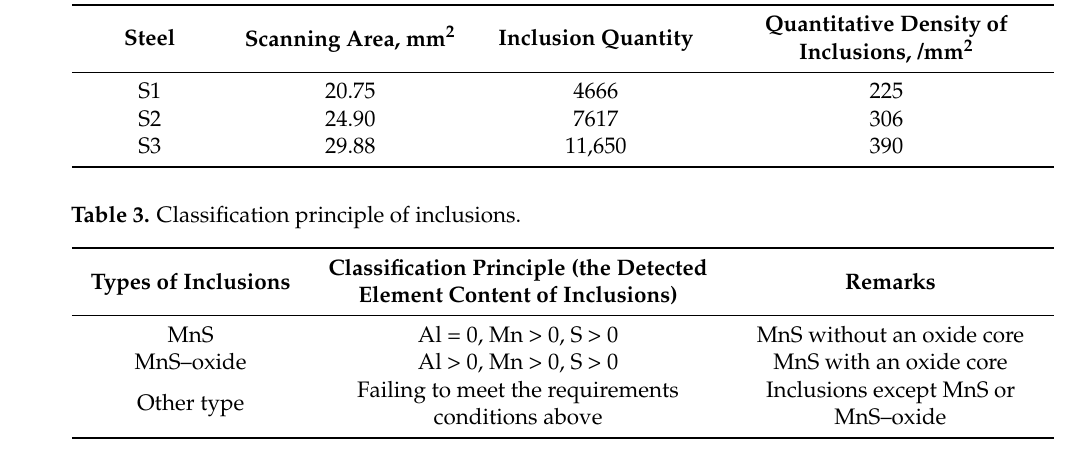
Figure 4. Types and percentage of sulfides in samples. 3.2. Morphology and Size of MnS Inclusions in Rolled Samples The morphology of inclusions affect the mechanical properties of steel. Diederichs [29] found that large-sized elongated MnS inclusions lead to the anisotropic properties of steel. Therefore, in this paper, the aspect ratio of sulfide in the rolled samples was ana- lyzed statistically. Sulfides with an aspect ratio of 3 or less were defined as spin- dle-shaped sulfides. The aspect ratio of all sulfides in the samples was statistical analyzed by ASPEX. The proportion of spindle-shaped MnS is shown in Figure 5. The proportion of spindle-shaped MnS–oxide was significantly higher than that of spindle-shaped MnS. The proportion of spindle-shaped MnS–oxide in sample S3 with Ca–Mg treatment was as high as 51.92%, while the proportion of spindle-shaped MnS in sample S2 with Mg treatment was just 10.07%. The proportions of spindle-shaped sulfides in samples S1, S2 and S3 were calculated, and the values are 23.31%, 19.39% and 43.24%, respectively.